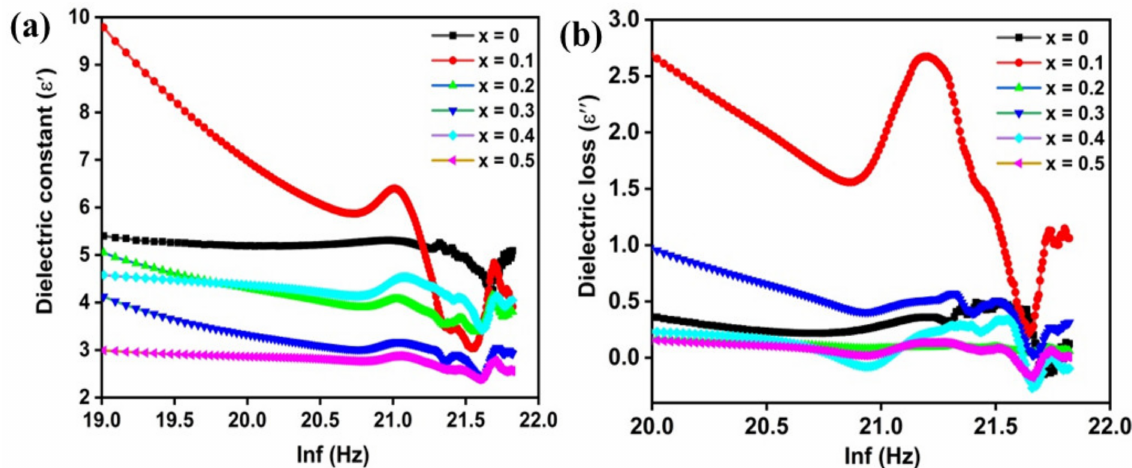
Figure 5. ( a ) Variation of dielectric constant ( a ) ε (cid:48) and ( b ) ε (cid:48)(cid:48) with frequency for pure cobalt ferrite (x = 0) and doped CoFe 2 − 2x Li x Zn x O 4 (x = 0.1–0.5) at room